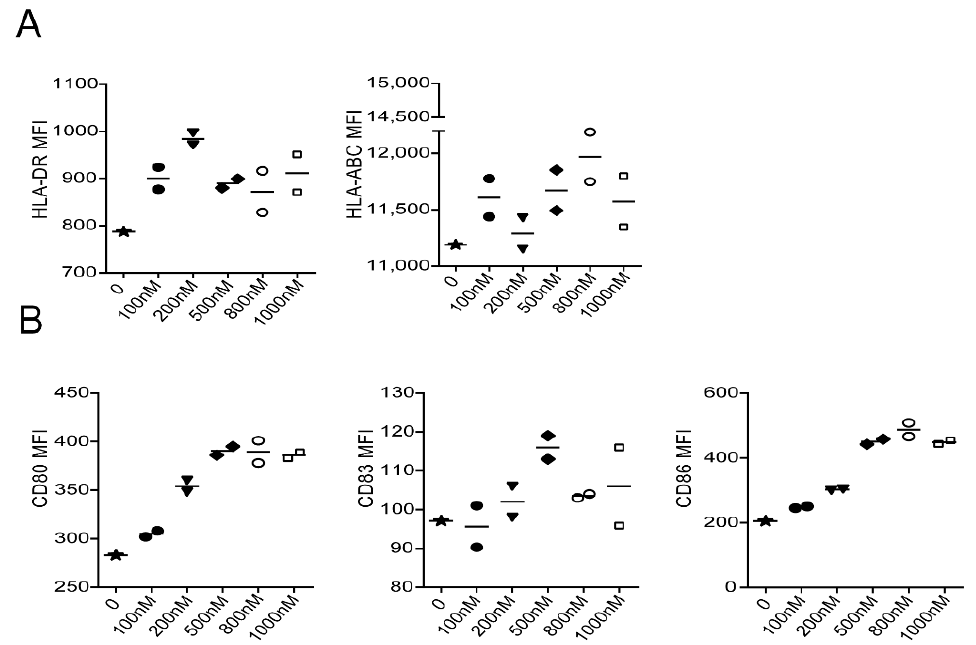
Figure 3. EDA-E7 concentration trial for DCs activation. Flow cytometry for antigen presenting molecular expression on DCs after stimulation with different dose of EDA-E7 ( A ); flow cytometry for costimulation molecule expression on DCs after EDA-E7 stimulation ( B ). n = 2 per group, data was presented as mean, MFI: mean flow index.